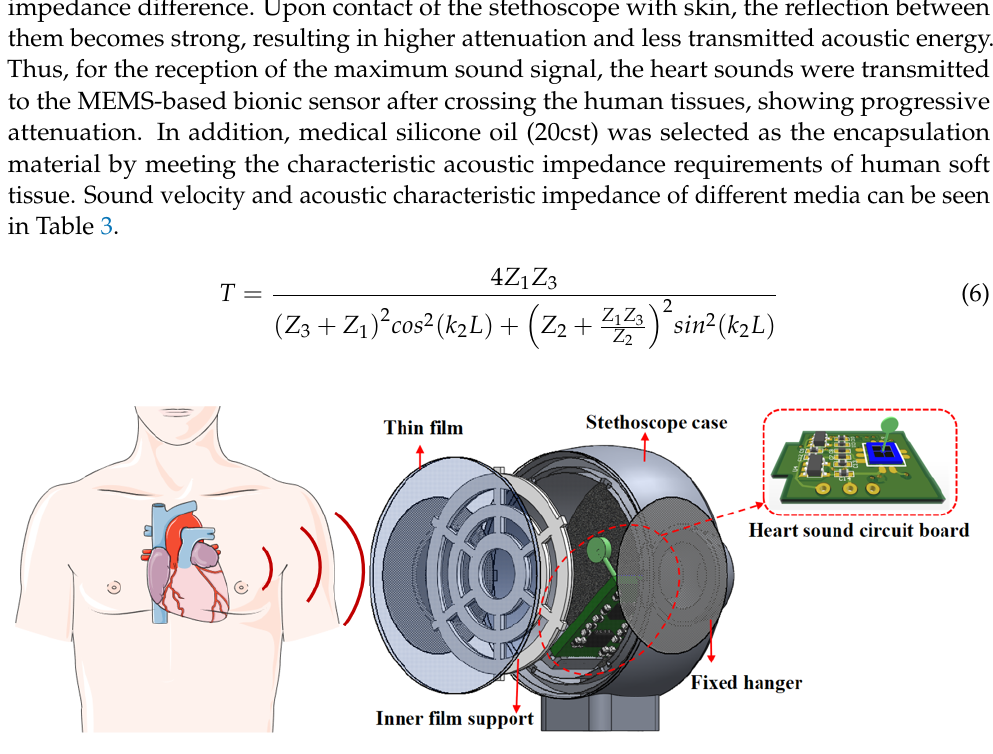
Figure 10. Schematic diagram of acoustic auscultation with bionic heart sound sensor. Table 3. Sound velocity and acoustic characteristic impedance of different media.